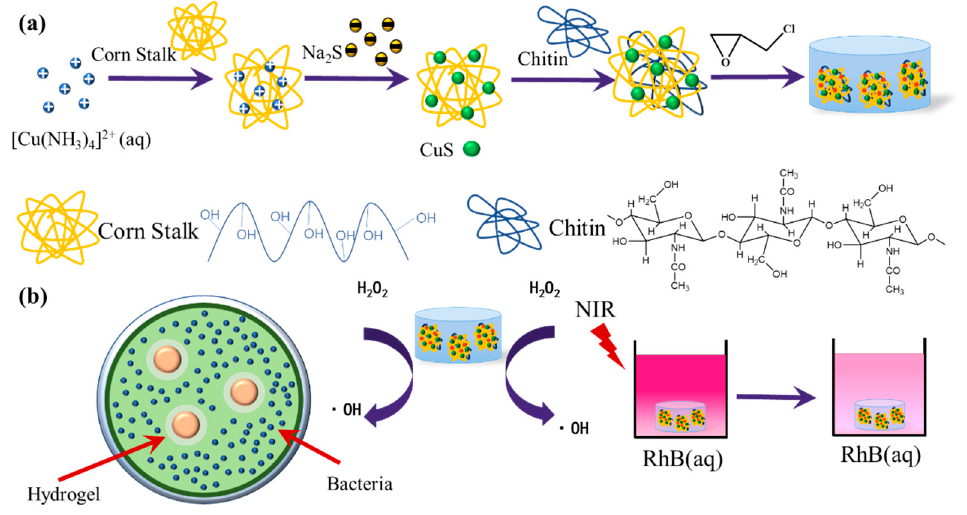
Figure 1. ( a ) Schematic diagram of the synthesis of CuS@corn stalk / chitin composite hydrogels; ( b ) the composite hydrogels used for antibacterial and photodegradation experiment.